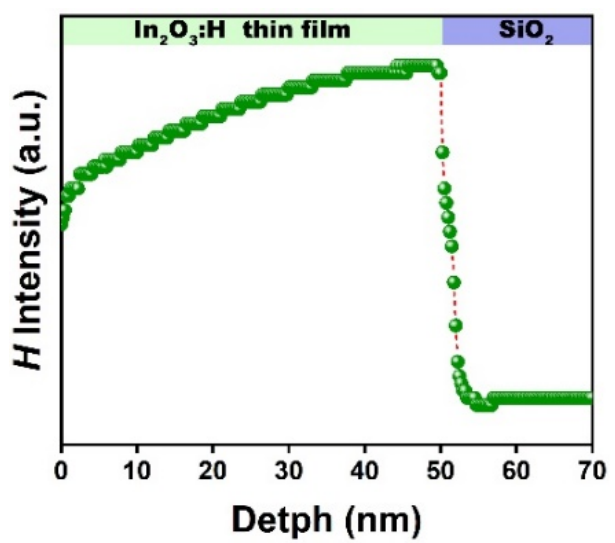
Figure 1. Hydrogen depth profile of the prepared In 2 O 3 :H films.